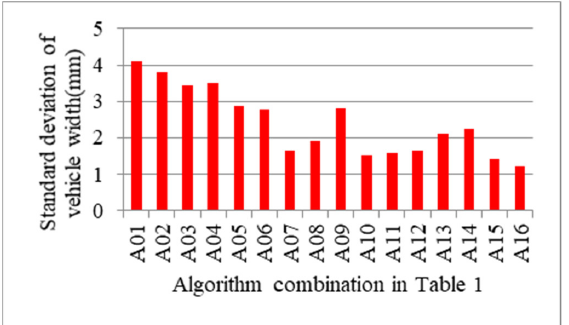
Figure 16. Standard deviation of vehicle height according to algorithm combination in Table 1.